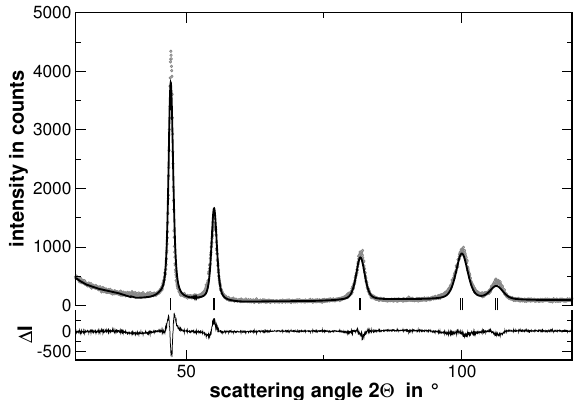
Figure A3. Experimental (points) and calculated (solid line) XRD patterns as well as their difference ∆ I (lower part) and Bragg positions (vertical lines) of homogenized AuNiPdPt.